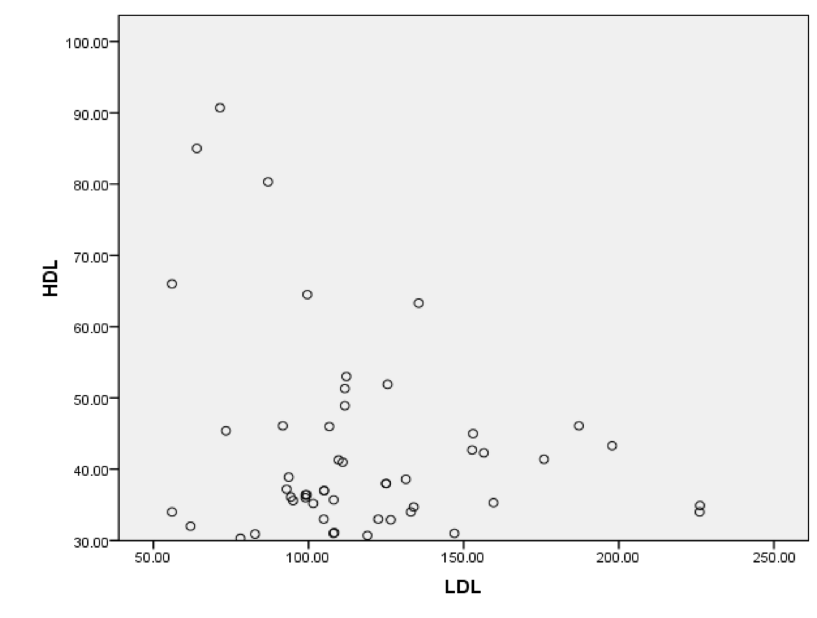
Figure 1: Figure shows the correlation between LDL-Cholesterol and